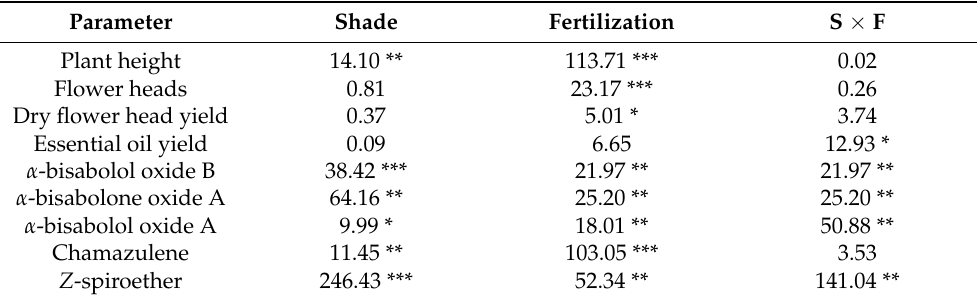
Table 2. Statistical significance of F ratios for growth parameters and essential oil main components of chamomile.